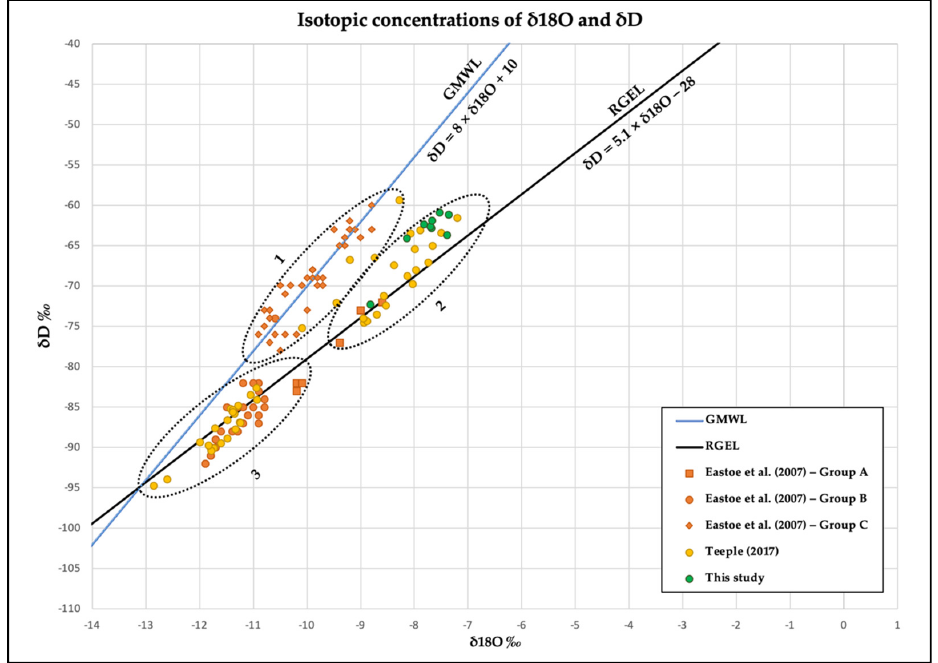
Figure 6. Plot of δ 18 O/ δ D (‰) in groundwater from this study, Eastoe et al. (2007) [12] and Teeple (2017) [11] was compared to the global meteoric water line (GMWL) and Rio Grande evaporation line (RGEL). The graph was divided into three groups, these groups considered all the samples in Appendix B. Group 1) is formed by water samples from the Mesilla and Hueco basins taken by Teeple (2017) [11] and Eastoe et al. (2007) [12]. Group 2) consists of samples from the Hueco Bolson and the Mesilla/Conejos-M é danos Basin aquifers, and they are samples taken by this study, Teeple (2017) [11] and Eastoe et al. (2007) [12]. Group 3) contains samples from the Mesilla Basin aquifer and the Bolson del Hueco; the samples were taken by Teeple (2017) [11] and Eastoe et al. (2007)